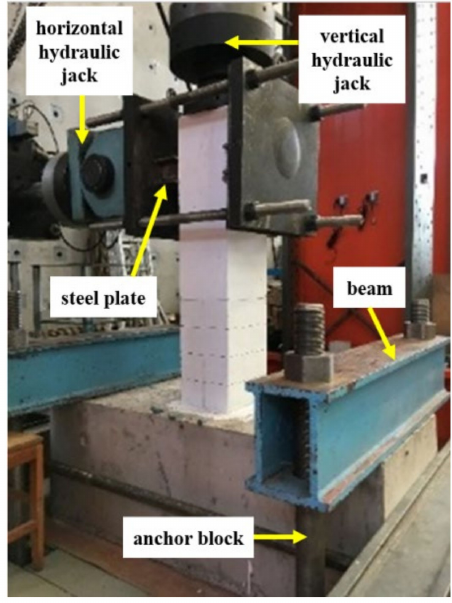
Figure 21. The specimen and the testing apparatus.